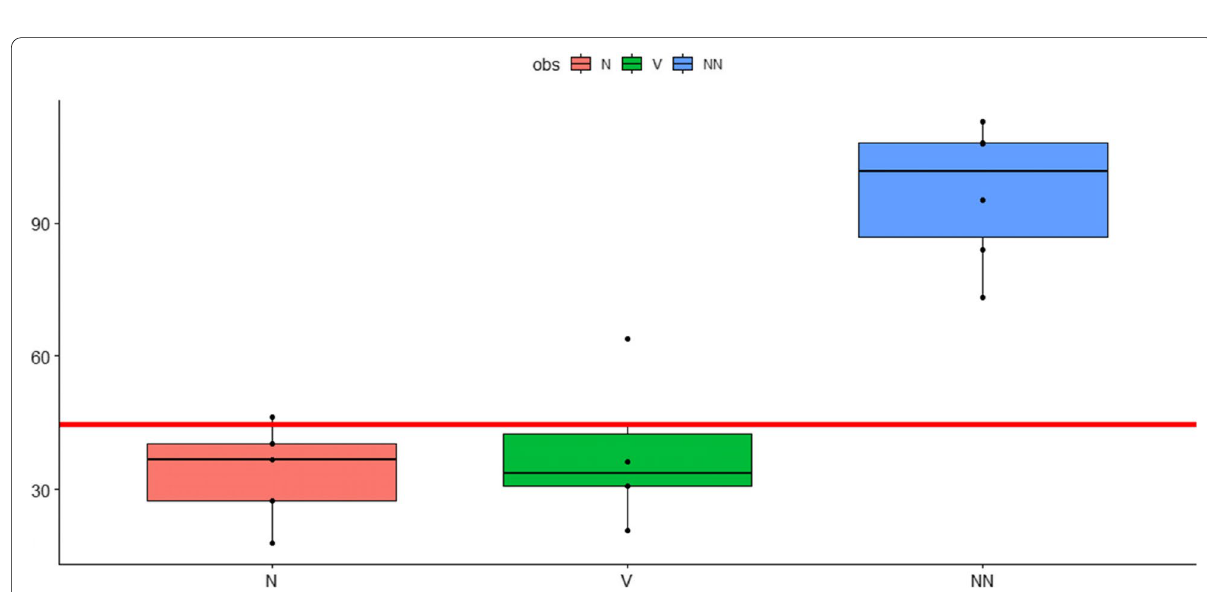
Fig. 3 Reserve capacity oxygen consumption rates (OCR). Reserve capacity OCR in pmol O 2 /min were measured before, after the first 10-pass OHT and after the second 10-pass OHT one week later. Cumulative data from six patients expressed as mean 0,614 (N versus V); 0,0,000,308 (N versus NN). COHEN: 3,84,696 (NN versus V); 0,3,071,484 (N versus V); 4,552,083 (N versus NN). ANOVA: 0,0,000,137 (NN versus V); 0,8,829,582 (N versus V); 0,000,011 (N versus NN). V: before OHT; N: after the first OHT; NN: after the 2. OHT (one week later). Y-Axis: pmol O2/min; X-axis: sampling